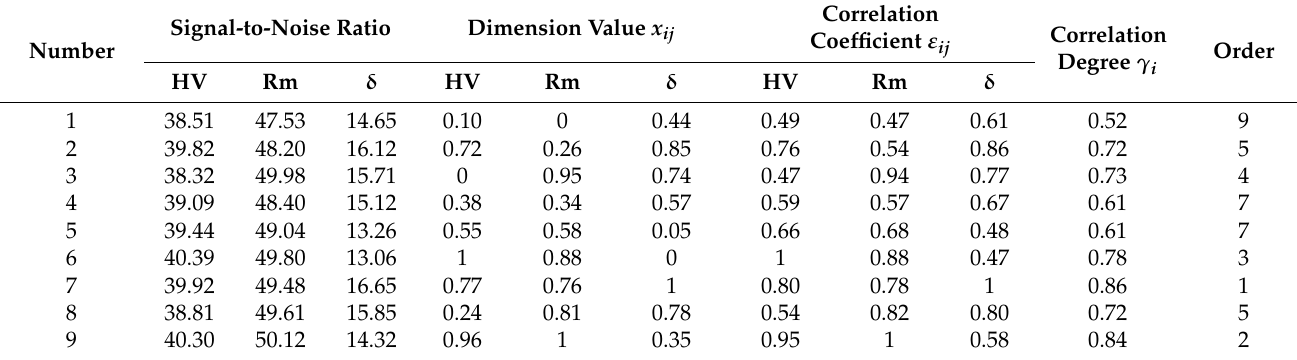
Table 6. Results of the grey correlation